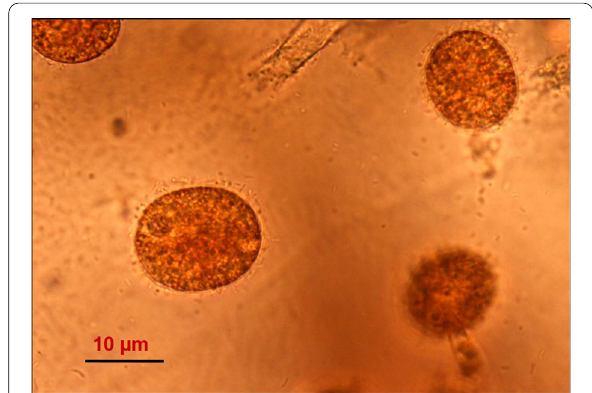
Fig. 3 Magnified view of V. pelagica inside the host copepod LM (Scale bar: 50 μm)